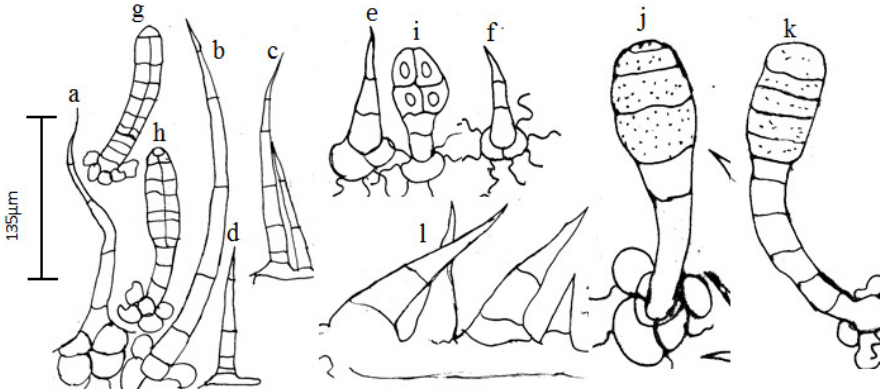
Fig. 4 . Trichome types in B. hispida (a, b, c, d, e, f and l) non-glandular trichomes and (g, h, I, j and k) glandular trichomes, (g, h and i) multicellular gland head and (j and k) clavate gland head